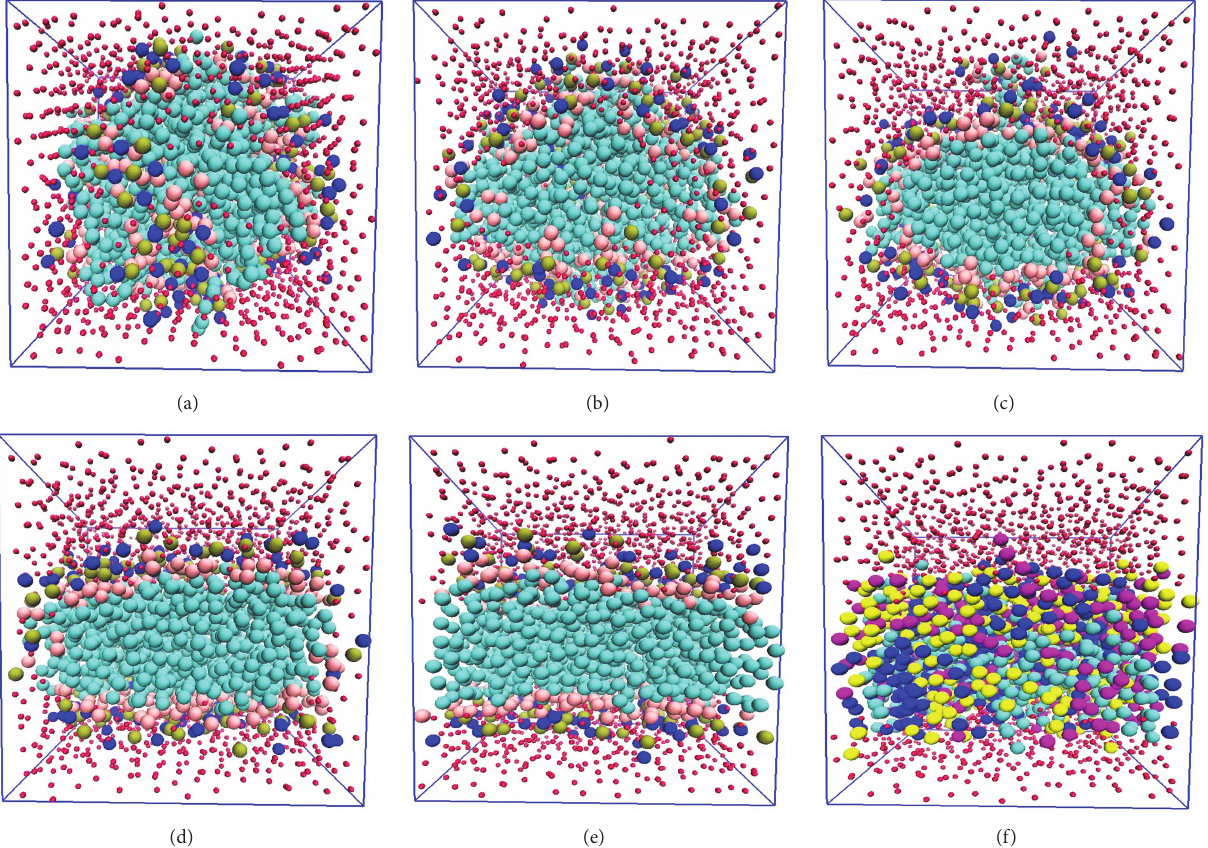
Figure 3: The snapshot pictures for the self-assembly of the mixed bilayer model system. The tail groups are represented by the cyan beads, GLY groups by pink beads, and NC3 and PO4 groups by blue and tan beads,